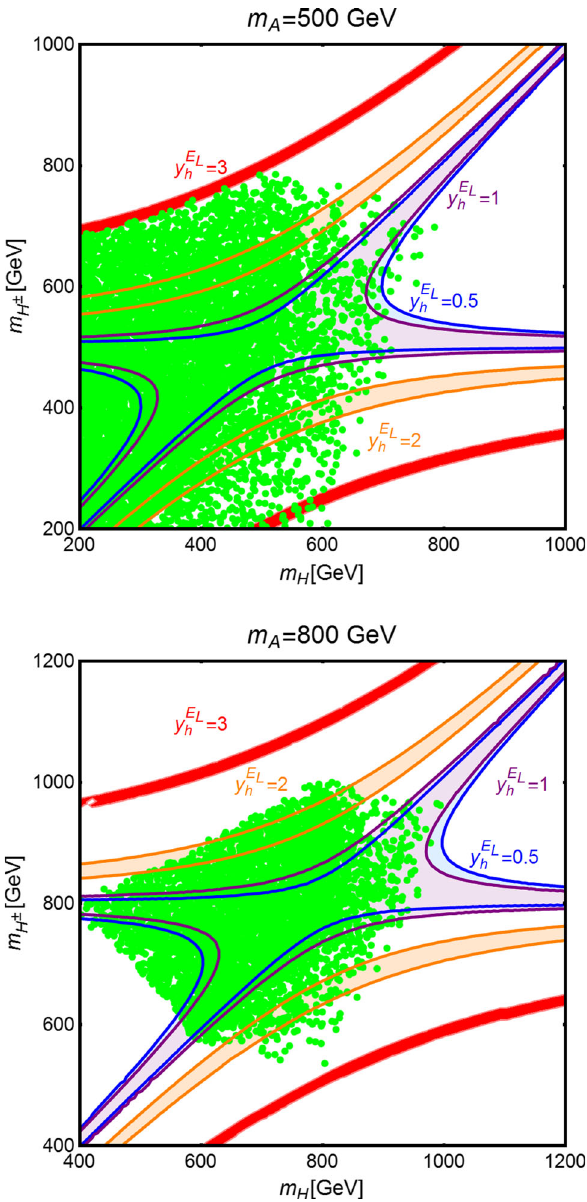
Fig. 5 Impact of EWPT constraints in the bidimensional plane ( m , m ) for two fixed assignations of m H A , i.e. 500 and 800 GeV. H ± The blue , purple , orange and red regions represent the allowed param- = 0 . 5 , 1 , 2 , 3. The green points repre- eter space for, respectively, y E L h sent the configurations allowed by the constraints reported in Eqs. (34) and (35)